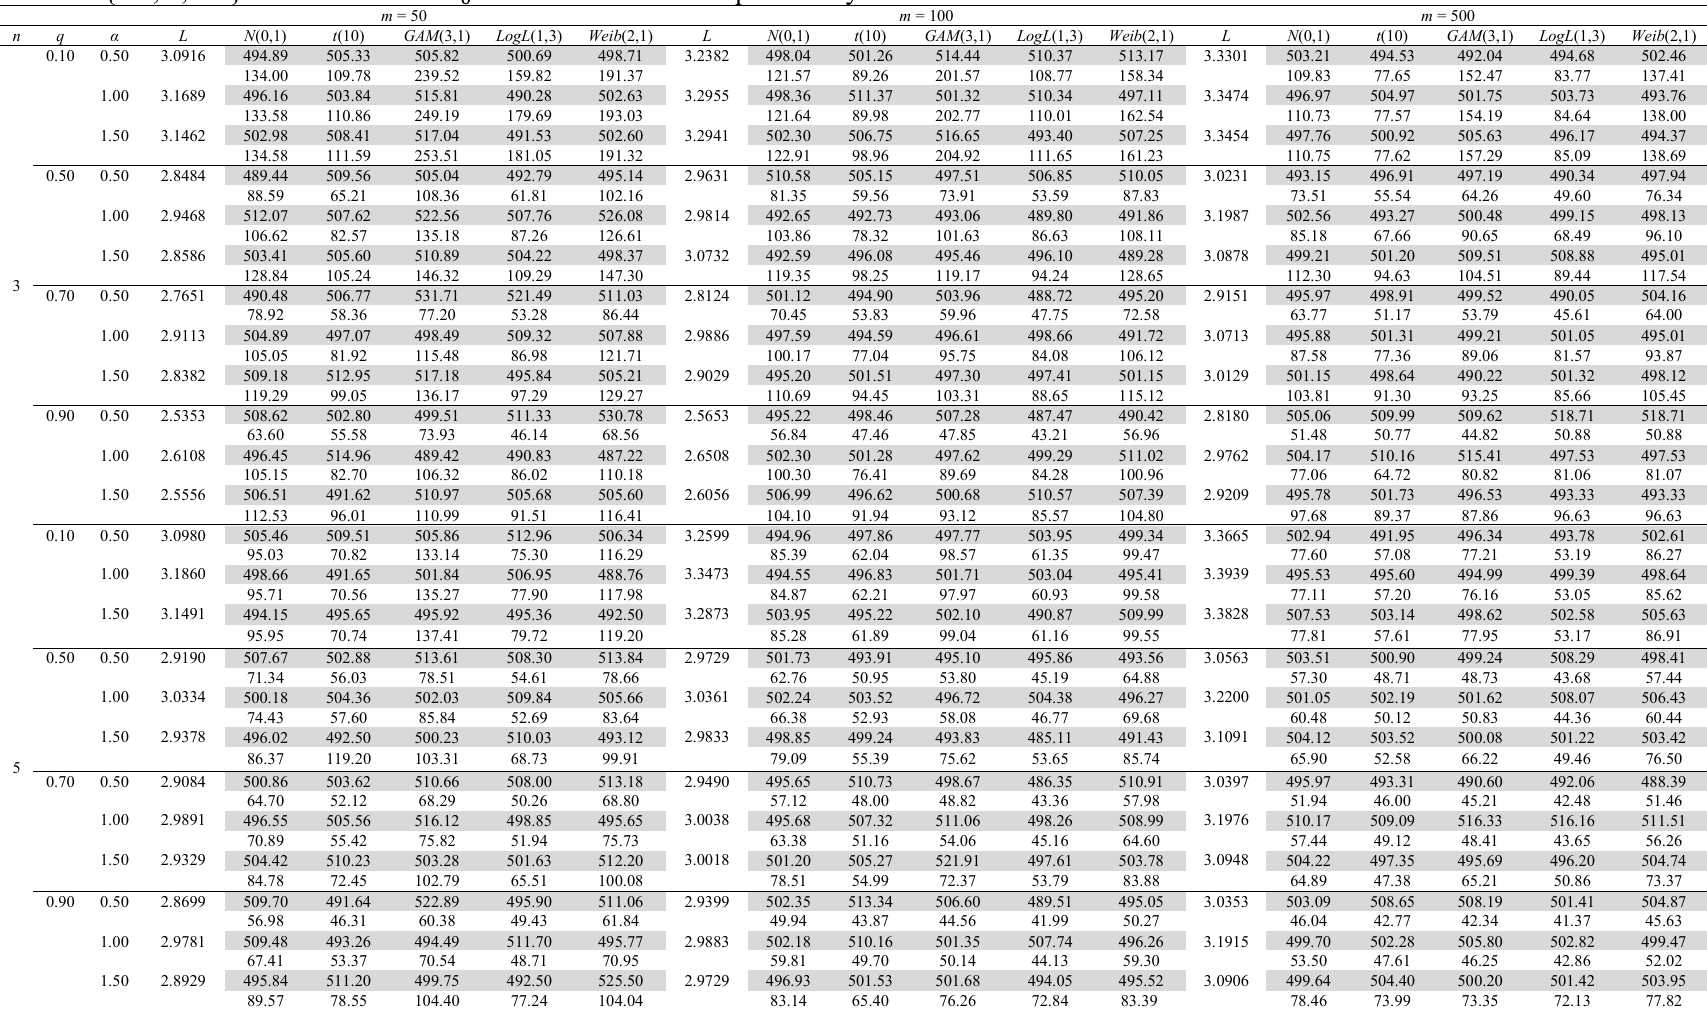
Case E attained 𝐴𝑅𝐿 (first row) and 𝐴𝐸𝑄𝐿 (second row) of the proposed W-GWMA control scheme when 𝑛 ∈ {3, 5}, 𝑚 ∈ {50, 100, 500}, 𝑞 ∈ {0.1, 0.5, 0.7, (cid:2868) 0.9} and 𝛼 ∈ {0.5, 1, 1.5} for a nominal 𝐴𝑅𝐿 of 500 under different probability distribution functions (cid:2868)